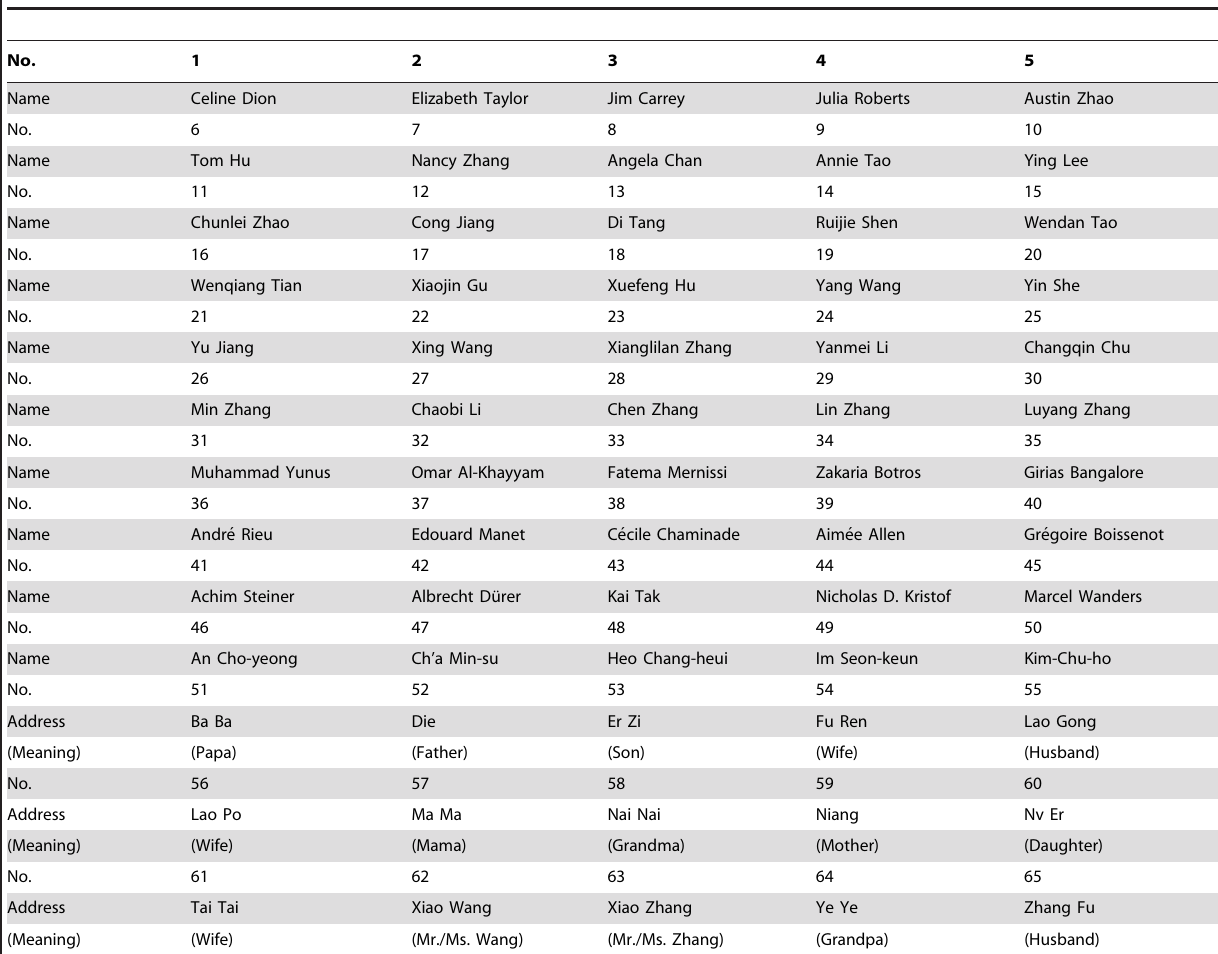
Table 4. List of Recorded Names.